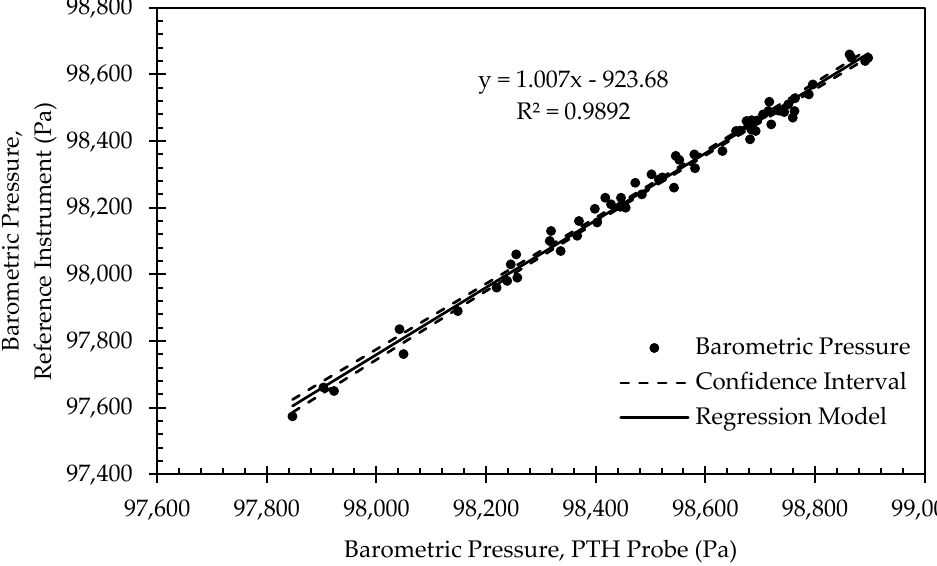
Figure 10. Regression model and corresponding confidence interval for barometric pressure calibra- tion data from representative PTH probe (SN: 0x0005).